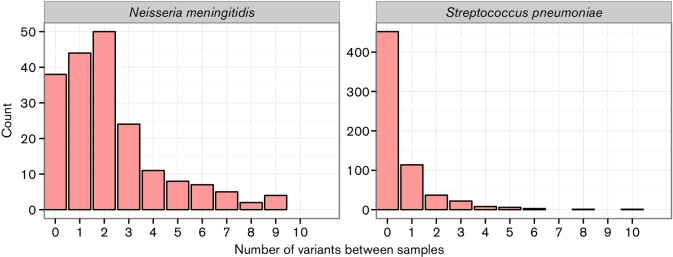
Histograms binned by number of variants between a blood/CSF sample pair, for both pathogens. Total pairs analysed: 674 S. pneumoniae, 195 N. meningitidis. SNPs are from mapping, INDELs are from Cortex. Three S. pneumoniae and one N. meningitidis sample with over 10 variants are not shown.